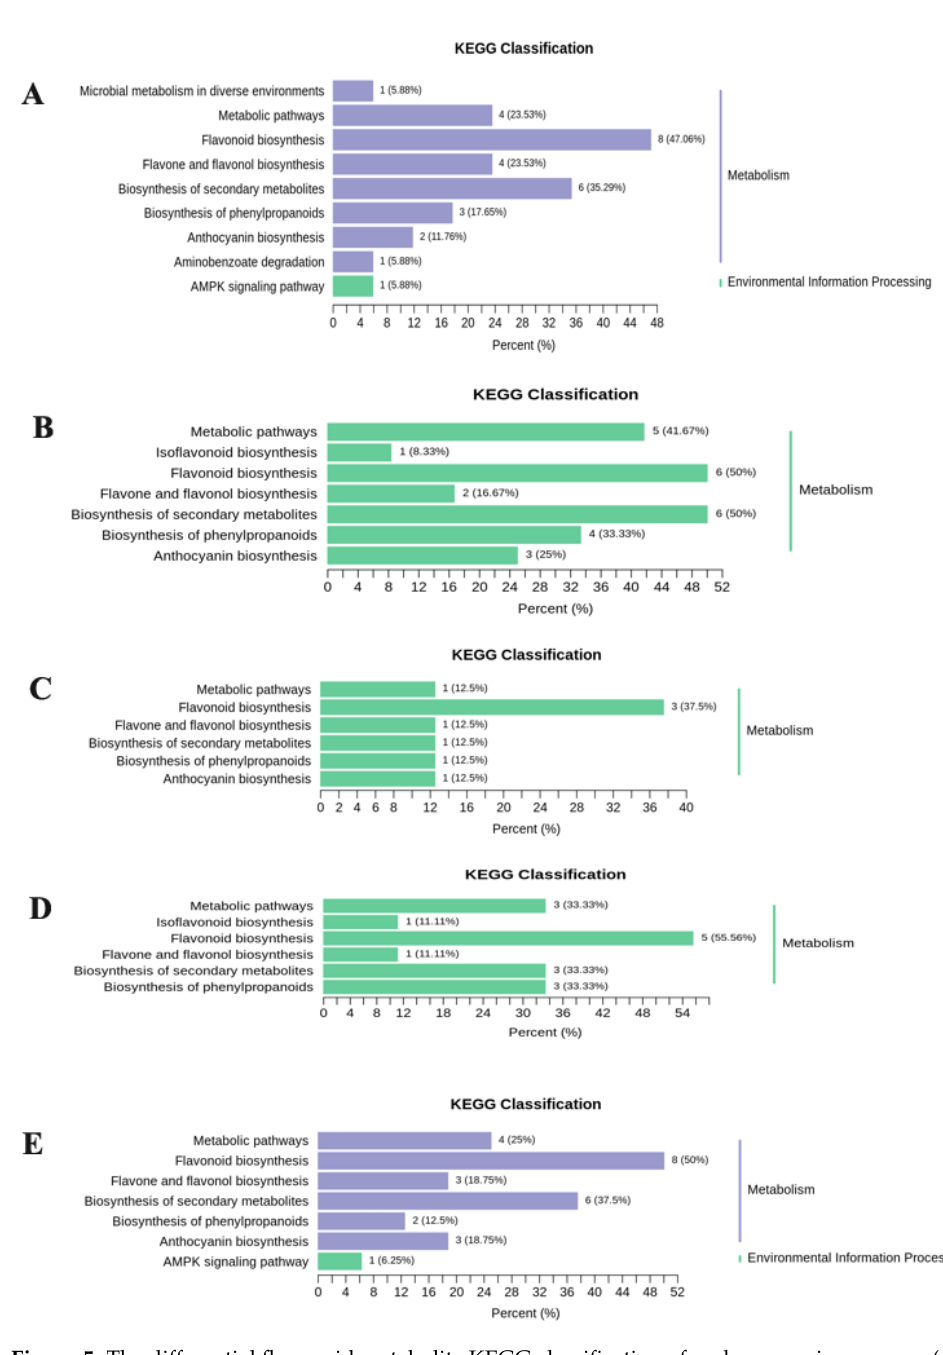
Figure 5. The differential flavonoid metabolite KEGG classification of each comparison group, ( A ) S1 versus S2; ( B ) S2 versus S3; ( C ) S3 versus S4; ( D ) S1 versus S1D; and ( E ) S2 versus S2D.